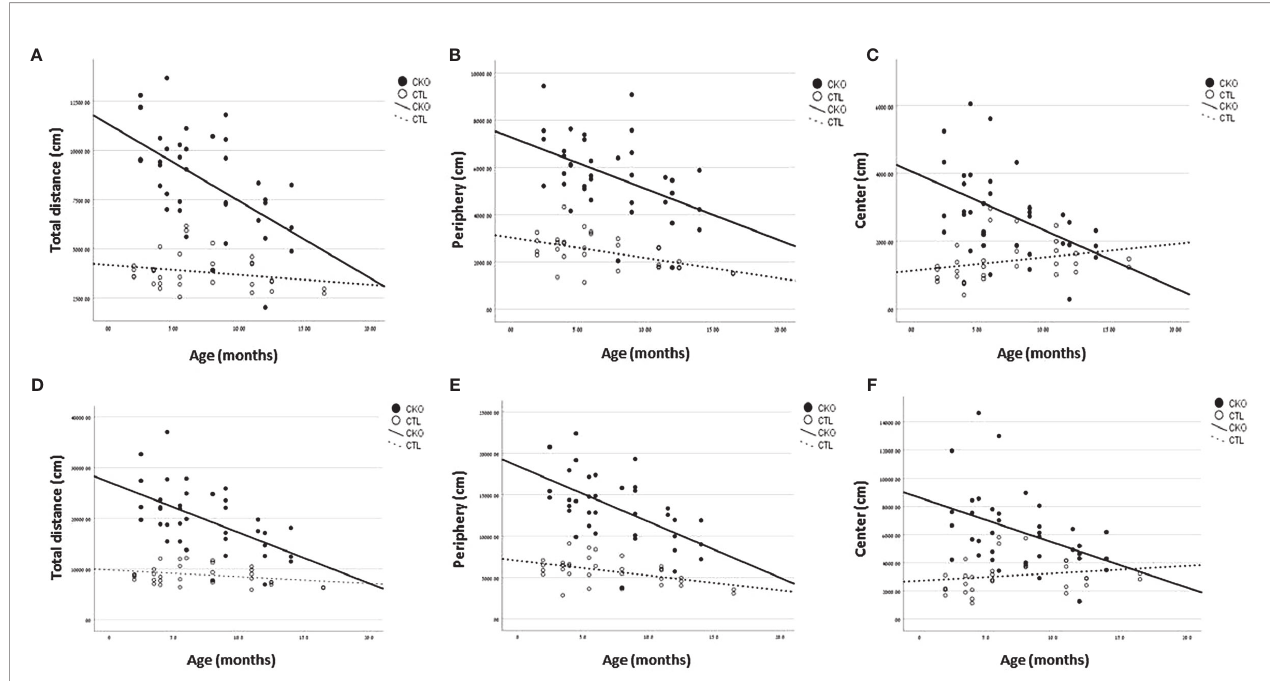
FIGURE 1 | Results of the open fi eld test (OFT). Graphs showing, for each of the groups (CKO and CTL), correlations between the animal age and (A, D) The total distance covered, (B, E) distance travelled in peripheral zone, (C, F) distance travelled in central zone. (A – C) - 10 minutes; (D – F) 30